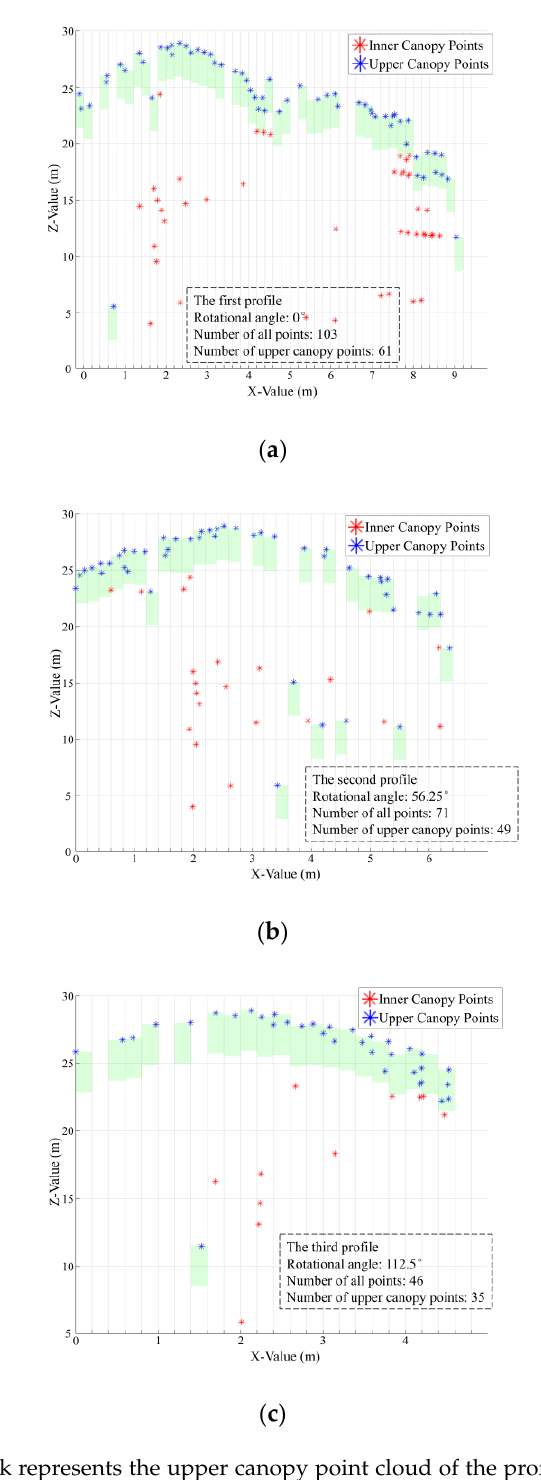
Figure 5. Blue asterisk represents the upper canopy point cloud of the profile selected using 0.2 m width uniformly-spaced lags. The lags are shown as the green rectangle to obtain the 3 m upper canopy points in each profile. ( a ), ( b ), and ( c ) represent the first, second, and third selected profiles, respectively, using the point number rules.